Question: Condense the content of this figure into a single sentence.
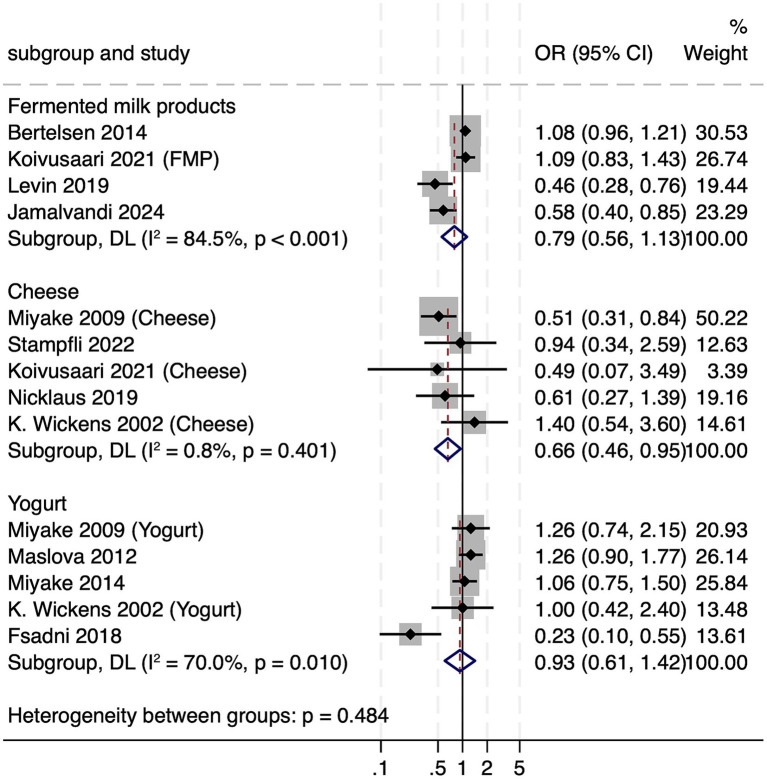
Answer: Forest plot of subgroup analysis by type of fermented dairy product.